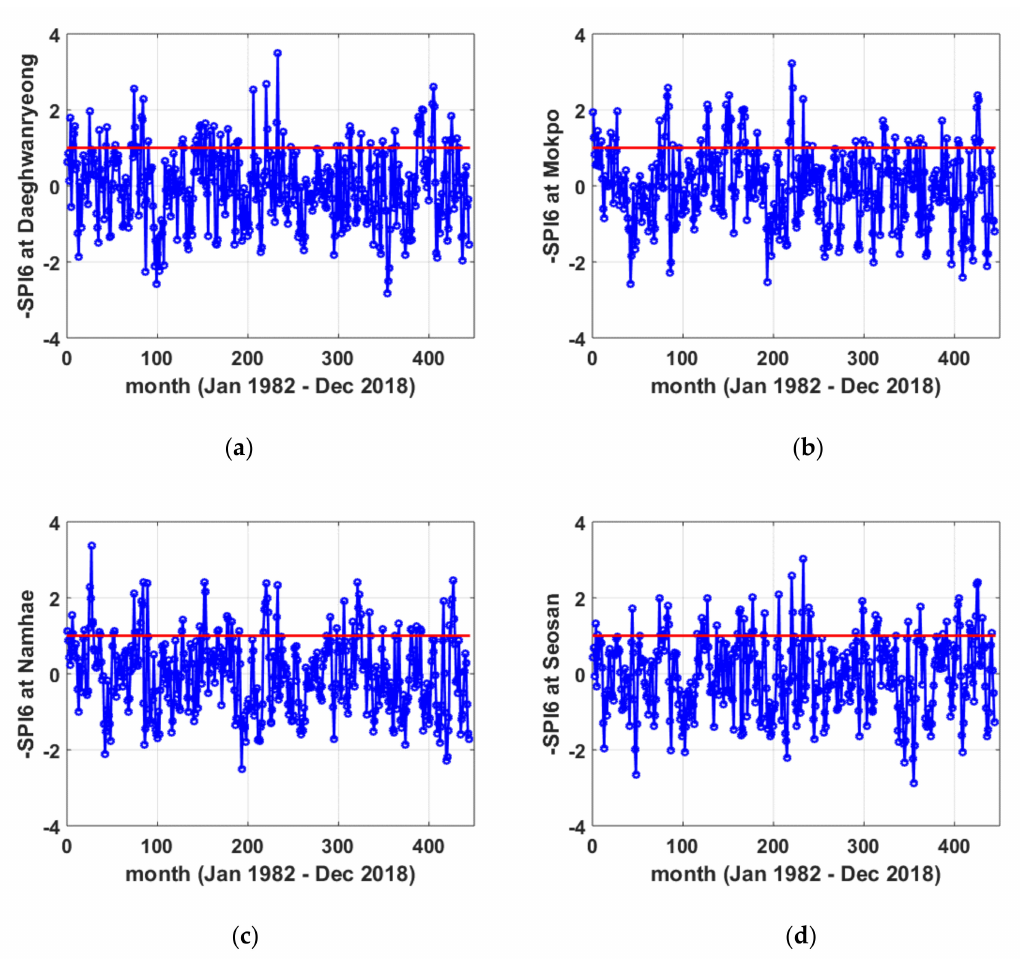
Figure 2. SPI monthly time series at ( a ) Daeghwanryeong, ( b ) Mokpo, ( c ) Namhae, and ( d ) Seosan. For reference, the red line indicates SPI’s drought criterion of −